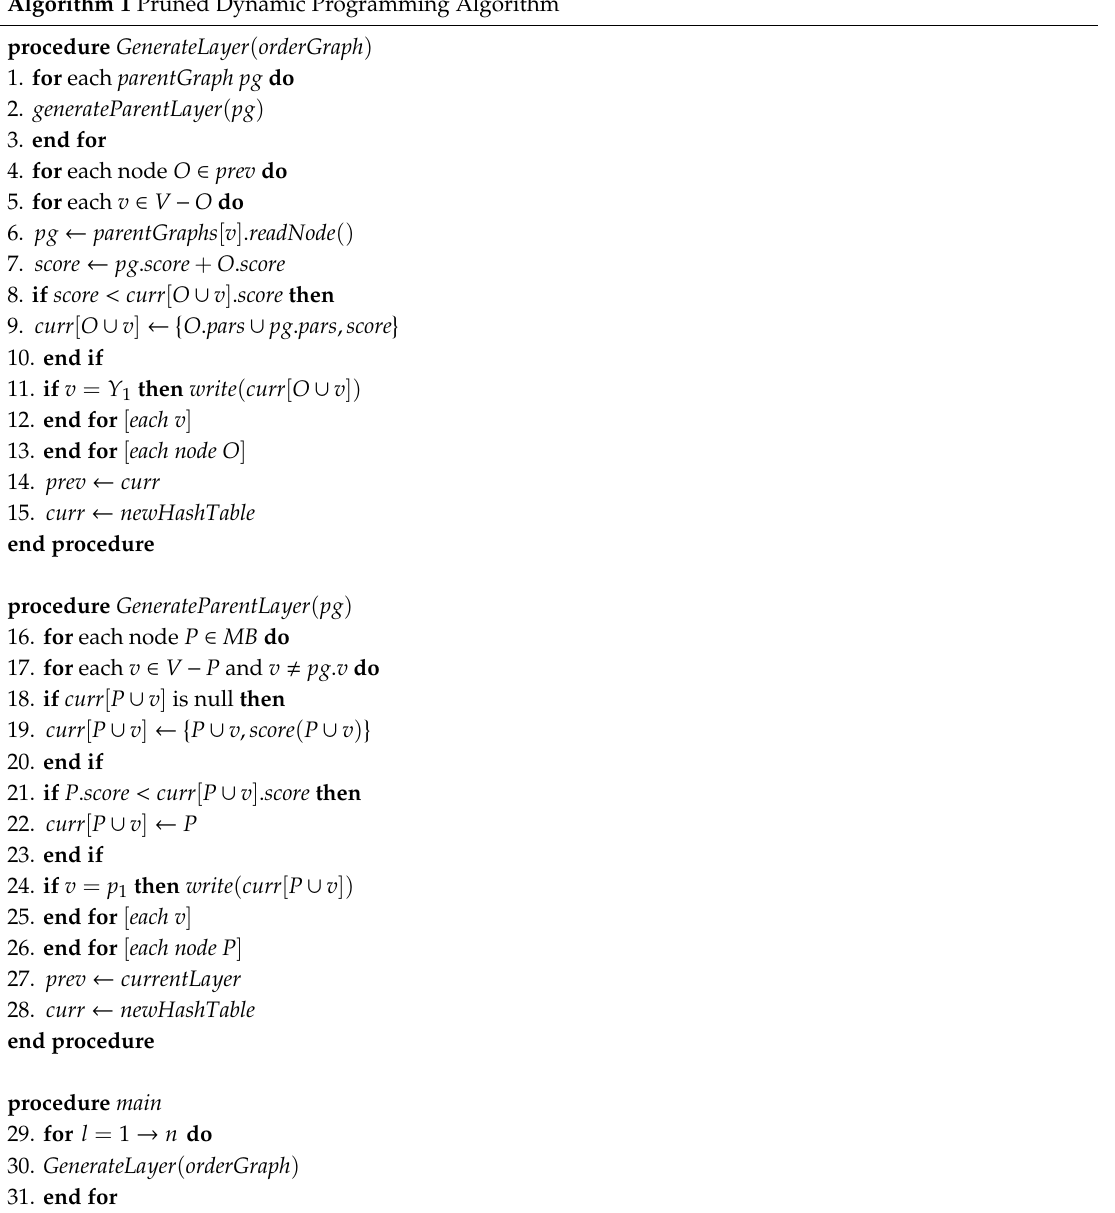
Algorithm 1 Pruned Dynamic Programming